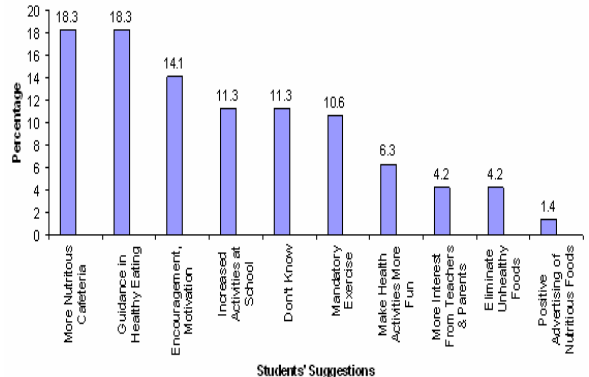
Figure 3: Students’ suggestions for improving their quality of